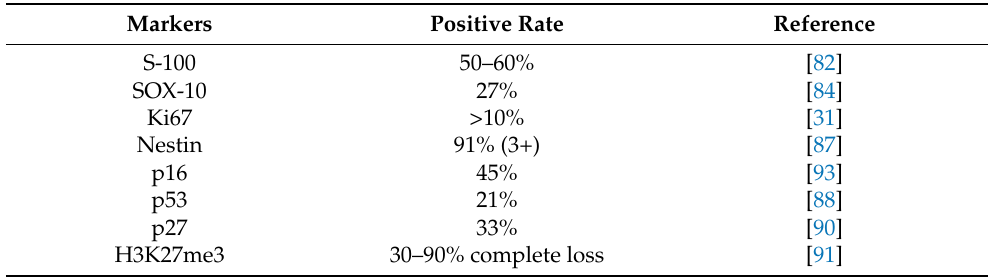
Table 1. Immunohistochemical markers for MPNST. This table illustrated the commonly used markers and their expression rate in